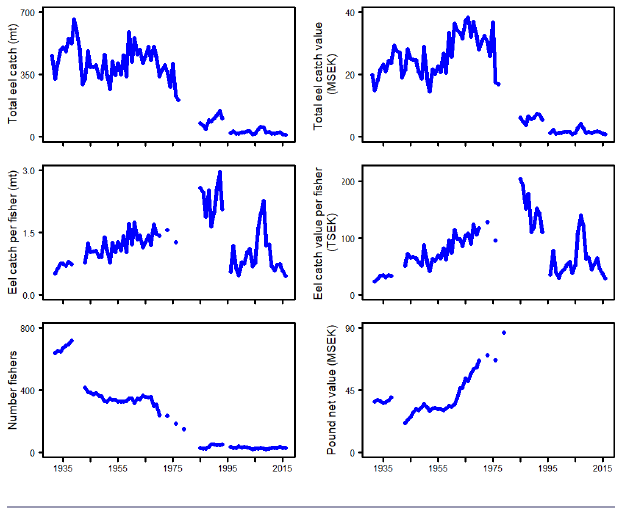
Fig. 3. Statistics showing the development of the pound net fishery in Kalmar County,